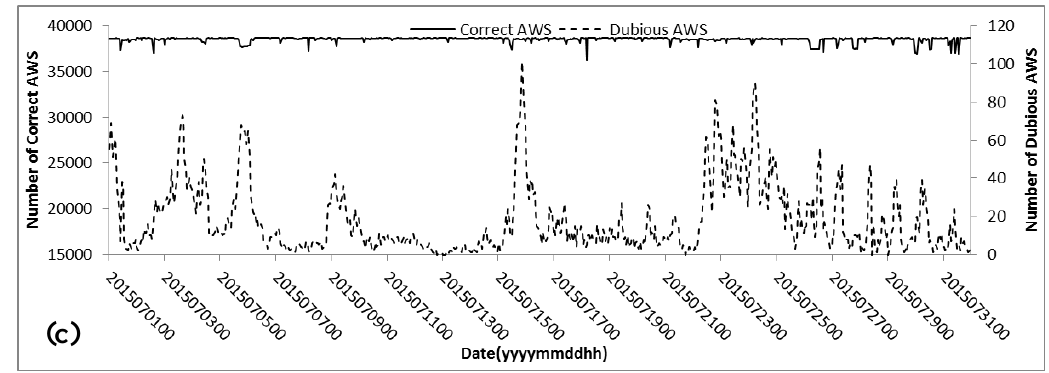
Figure 1. ( a ) Spatial distribution of about 40,000 Automatic Weather Station (AWS) (red point) and three sub-regions, ( b ) AWS observed hourly precipitation at 02 UTC 8 June 2015 and ( c ) time series of correct and dubious AWS numbers from 00 UTC 1 July to 23Z 31 July 2015.